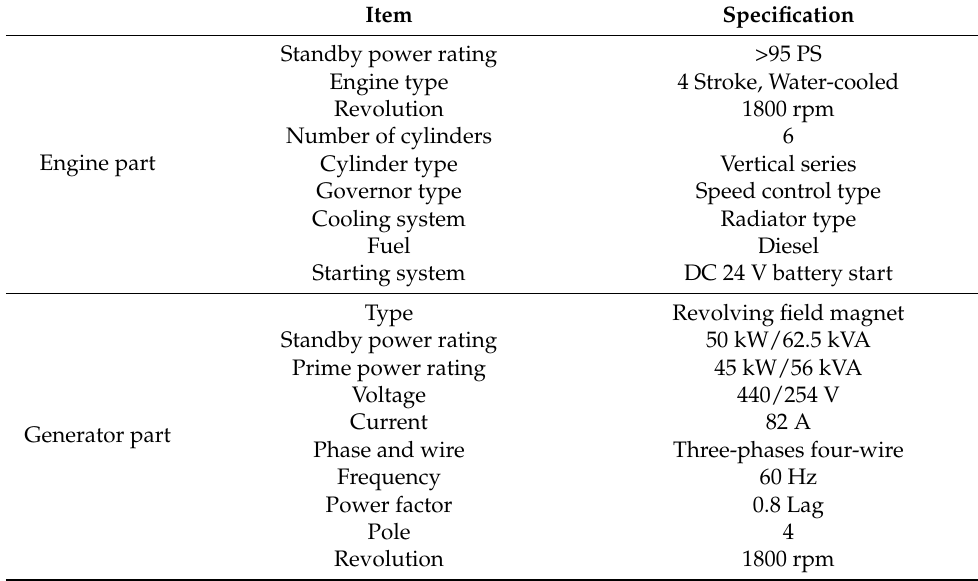
Table 3. Hybrid testbed and generator engine specifications.